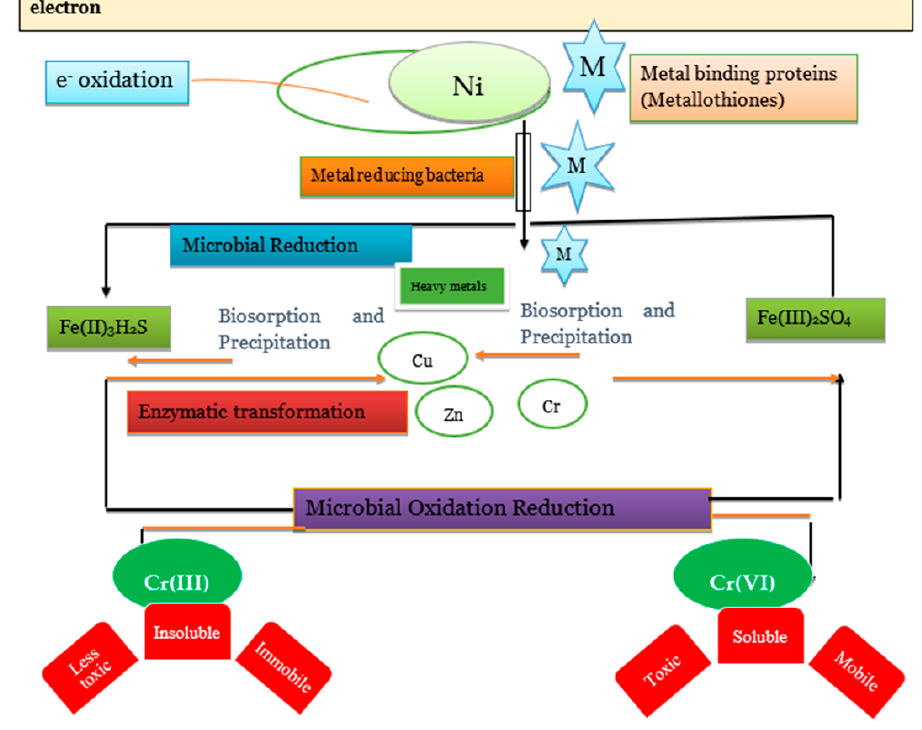
Figure 1. Mechanism of heavy metal removal from contaminated soils by microorganisms [220]. Microorganisms biodegrade pesticides or their by-products in the environs, or else they get accumulated in different environs and eventually become part of soil humus and enter the food chain [221]. The possibilities of environmental pesticide fate are depicted in Figure 2. The biodegradation mechanism and proposed pathway of degradation of some most important pesticides by microbes have been proposed. Chlorpyrifos, an OP pesticide extensively utilized to manage a variety of crop insects, is toxic to the environment and deadly to mammals. Hence, it is essential to eliminate it [222]. The degradation pathway for chlorpyrifos degradation by a bacterial strain, Ochrobactrum sp. JAS2, was proposed by Abraham and Silambarasan [223] (Figure 3). Initially, the parent pesticide, chlorpyrifos, was hydrolyzed to generate TCP (3,5,6-trichloro-2-pyridinol) and DETP (diethylthiophosphoric acid). TCP was then further converted by ring breakage, leading to its complete detoxifi- cation. However, in the case of DDT, an OC pesticide used extensively since the 1940s to eliminate malaria mosquitos [216], a consortium of brown-rot fungus Fomitopsis pinicola and the bacterium Ralstonia pickettii is capable of utilizing dichlorodiphenyltrichloroethane (DDT) as the main source of energy and carbon. DDT was first transformed to DDE and DDD by dichlorination at the trichloromethyl group, and then into DDMU (Figure 4). Similarly, in carbaryl pesticide, the carbaryl esterase enzyme broke an ester bond within the carbaryl pesticide at first, resulting in the formation of naphthol and methylamine.